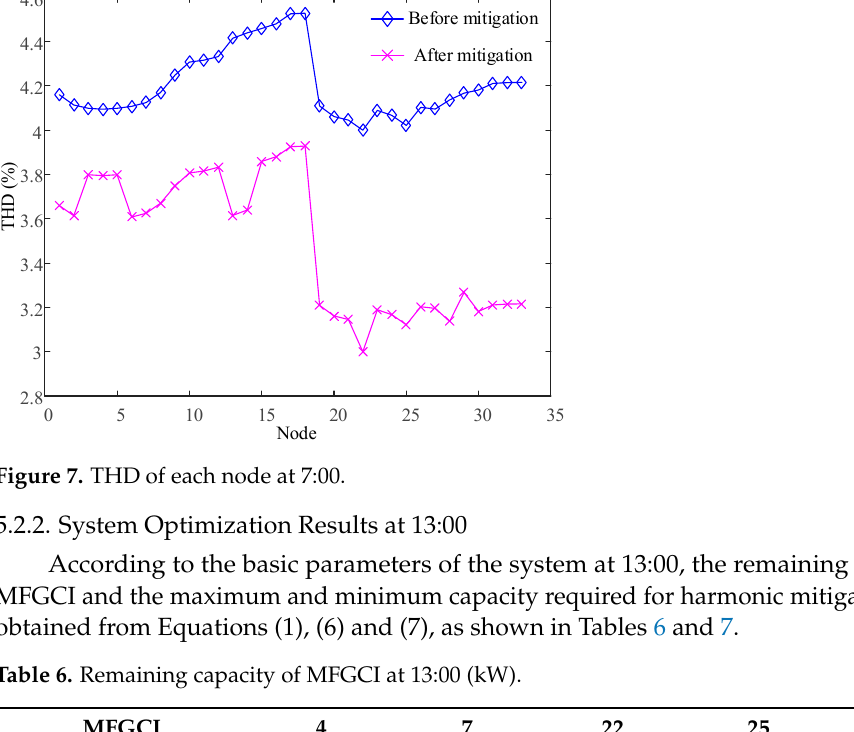
Table 6. Remaining capacity of MFGCI at 13:00 (kW).